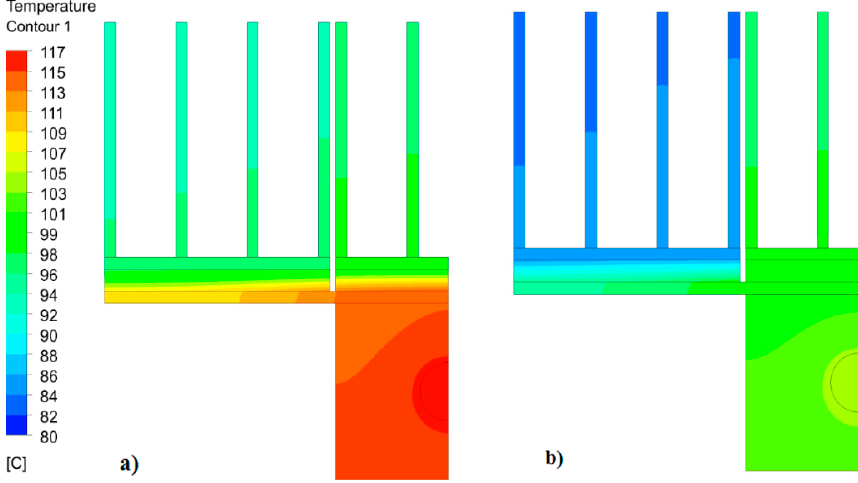
Figure 10. Temperature distribution Q = 130 W ( a ) case A ( b ) case B after 60 minutes.